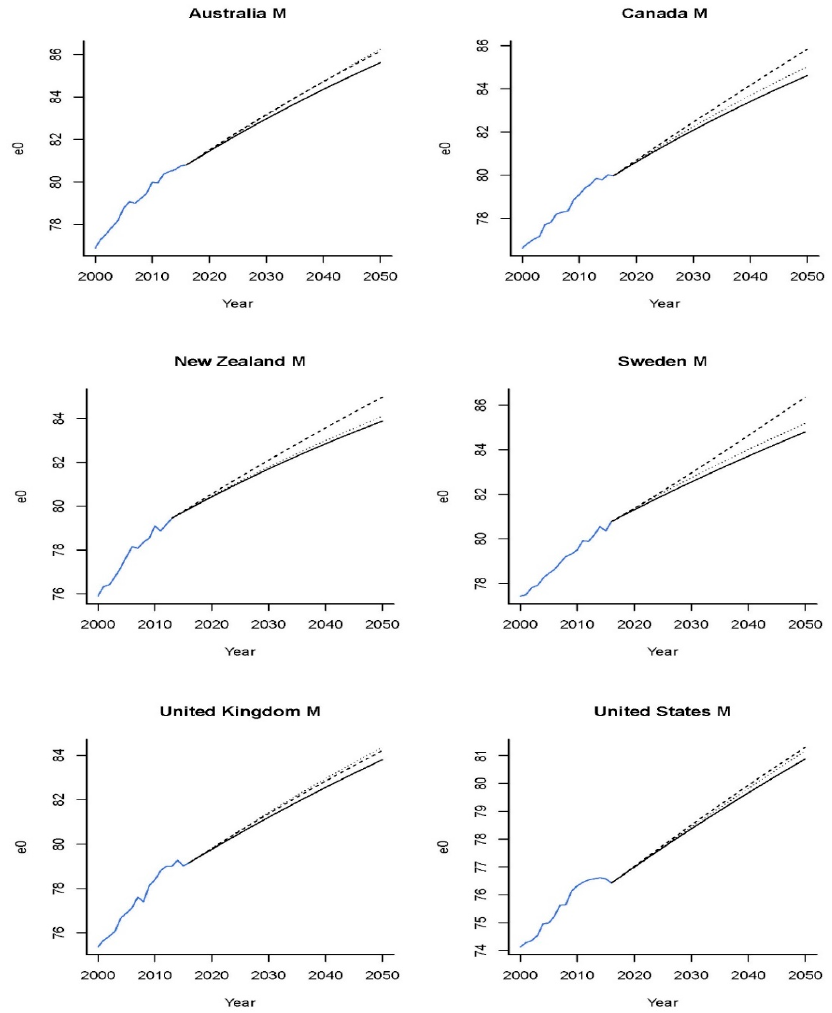
Figure 6. Observed (blue lines) and projected (black lines) life expectancy at birth ( e 0 ), calibrated on mortality data from the whole sample period. The solid lines correspond to forecasts under the original Lee-Carter model. The dashed and dotted lines refer to projections from the Fourier Lee-Carter model and cubic Lee-Carter model, respectively.